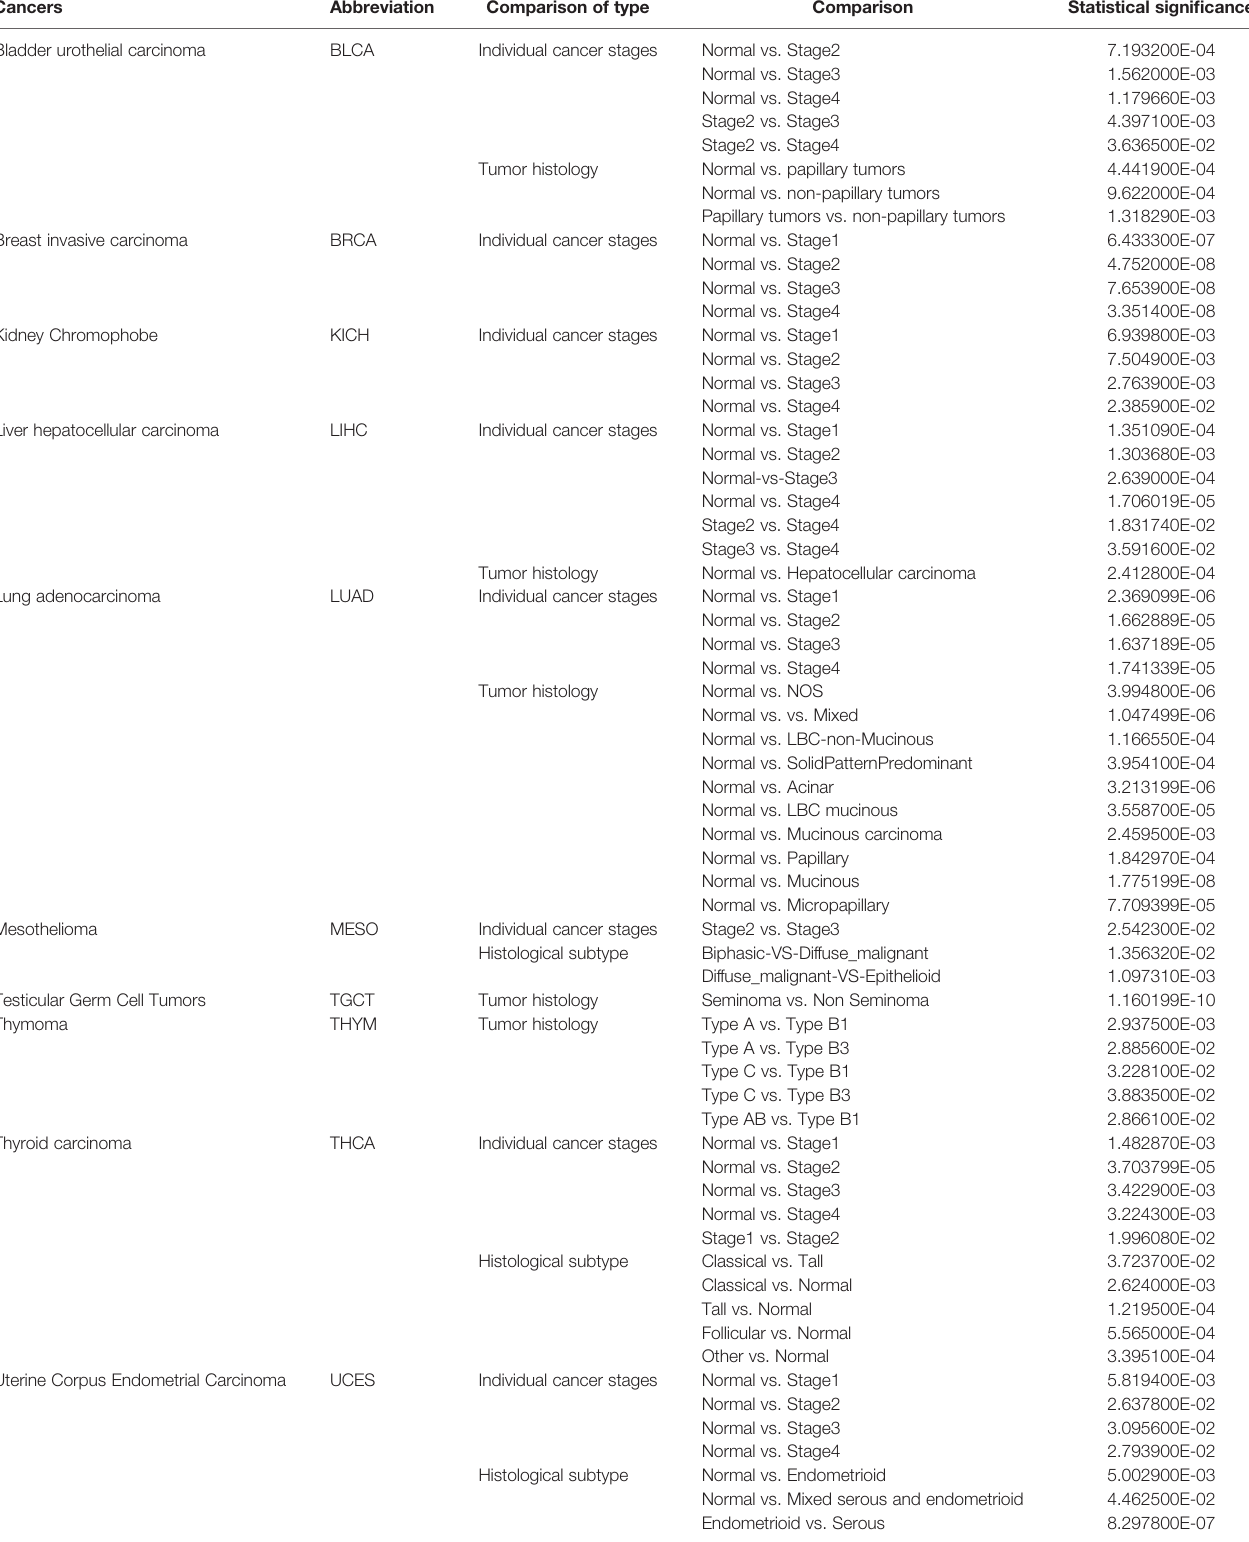
TABLE 1 | Expression of SOCS3 in different cancers on histological